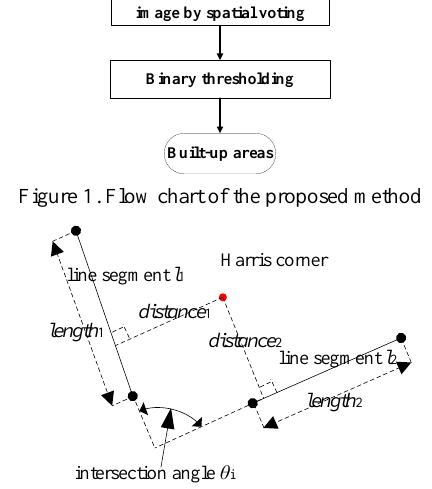
Figure 2. The construction of a righ angle corner and two